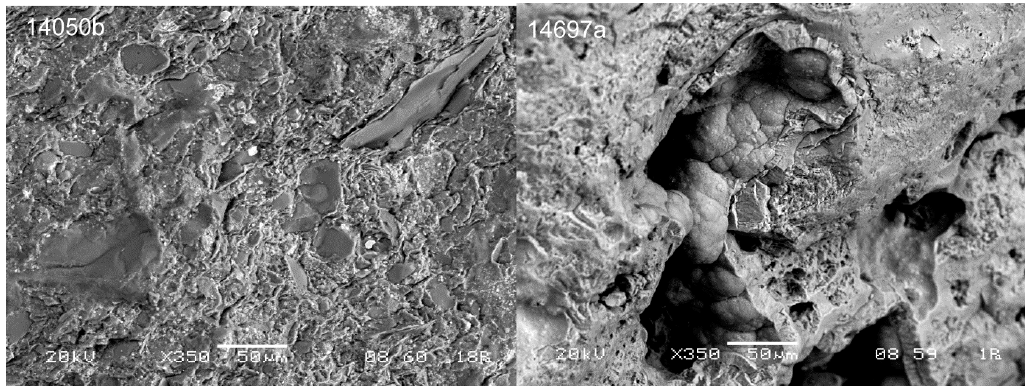
Figure 3. SEM images (BSE, back scattered electron mode) of the surface of two geological pieces studied, showing the coarse inclusions in one shale (14050b) and the matrix of iron oxide crystals in one ferricrete (14697a).